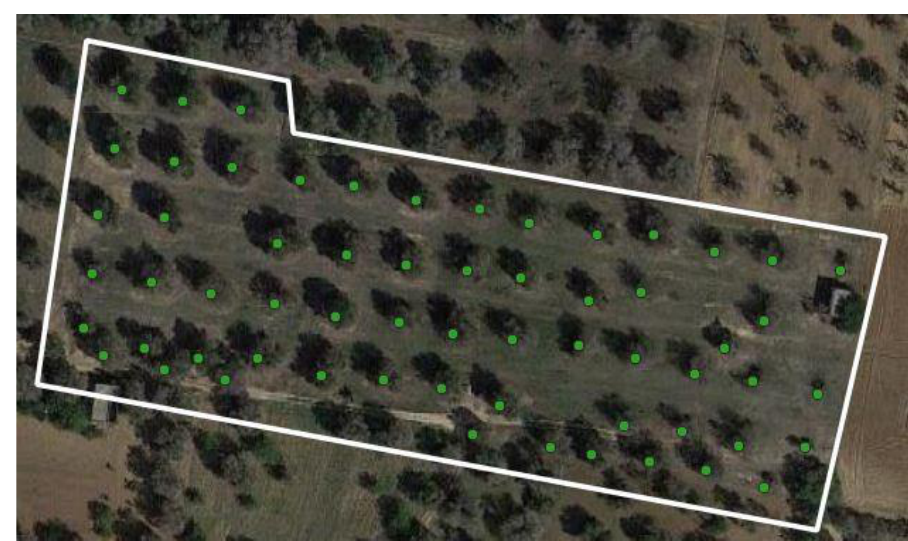
Figure 1. The soil sampling design in the olive grove of Oria.